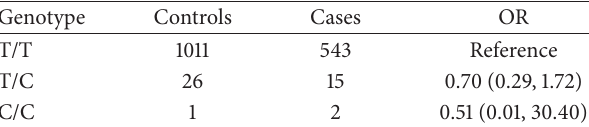
Table 2: Logistic regression analysis showing no association between individual SNP and dementia.